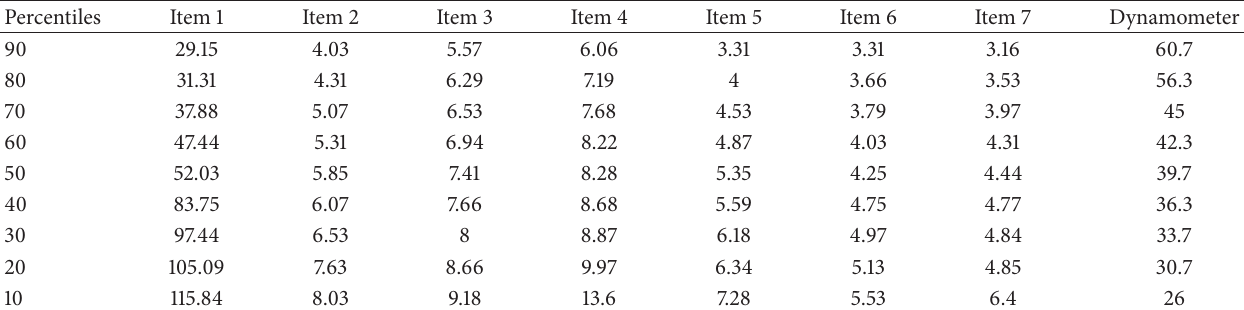
Table 19: 𝑛 = 19 , females, 20–94, dominant hand, educational instruction: elementary school.